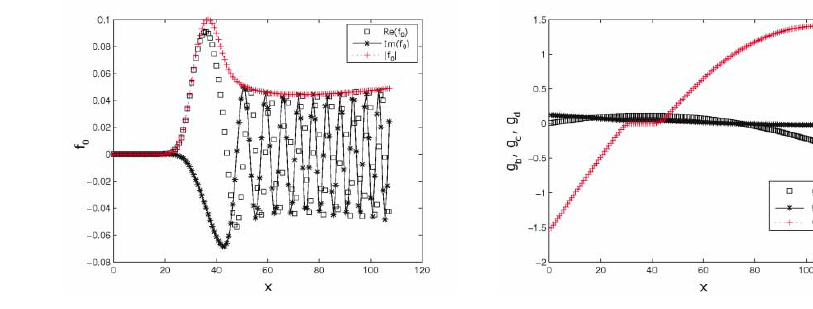
Figure 1. Complex initial function f 0 . Figure 2. Auxiliary functions g b , g c , g d